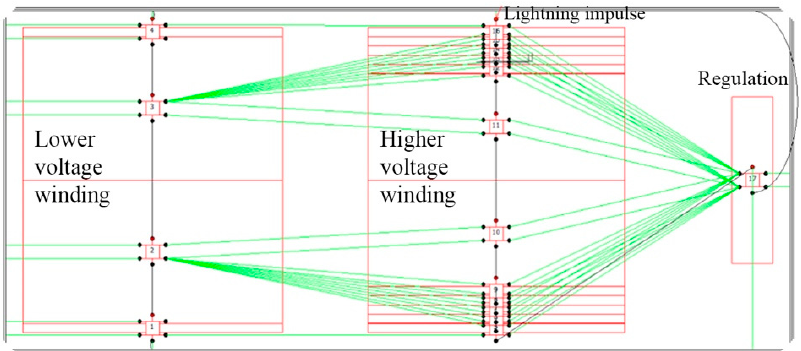
Figure 7. BIL simulation in CoreTransient.